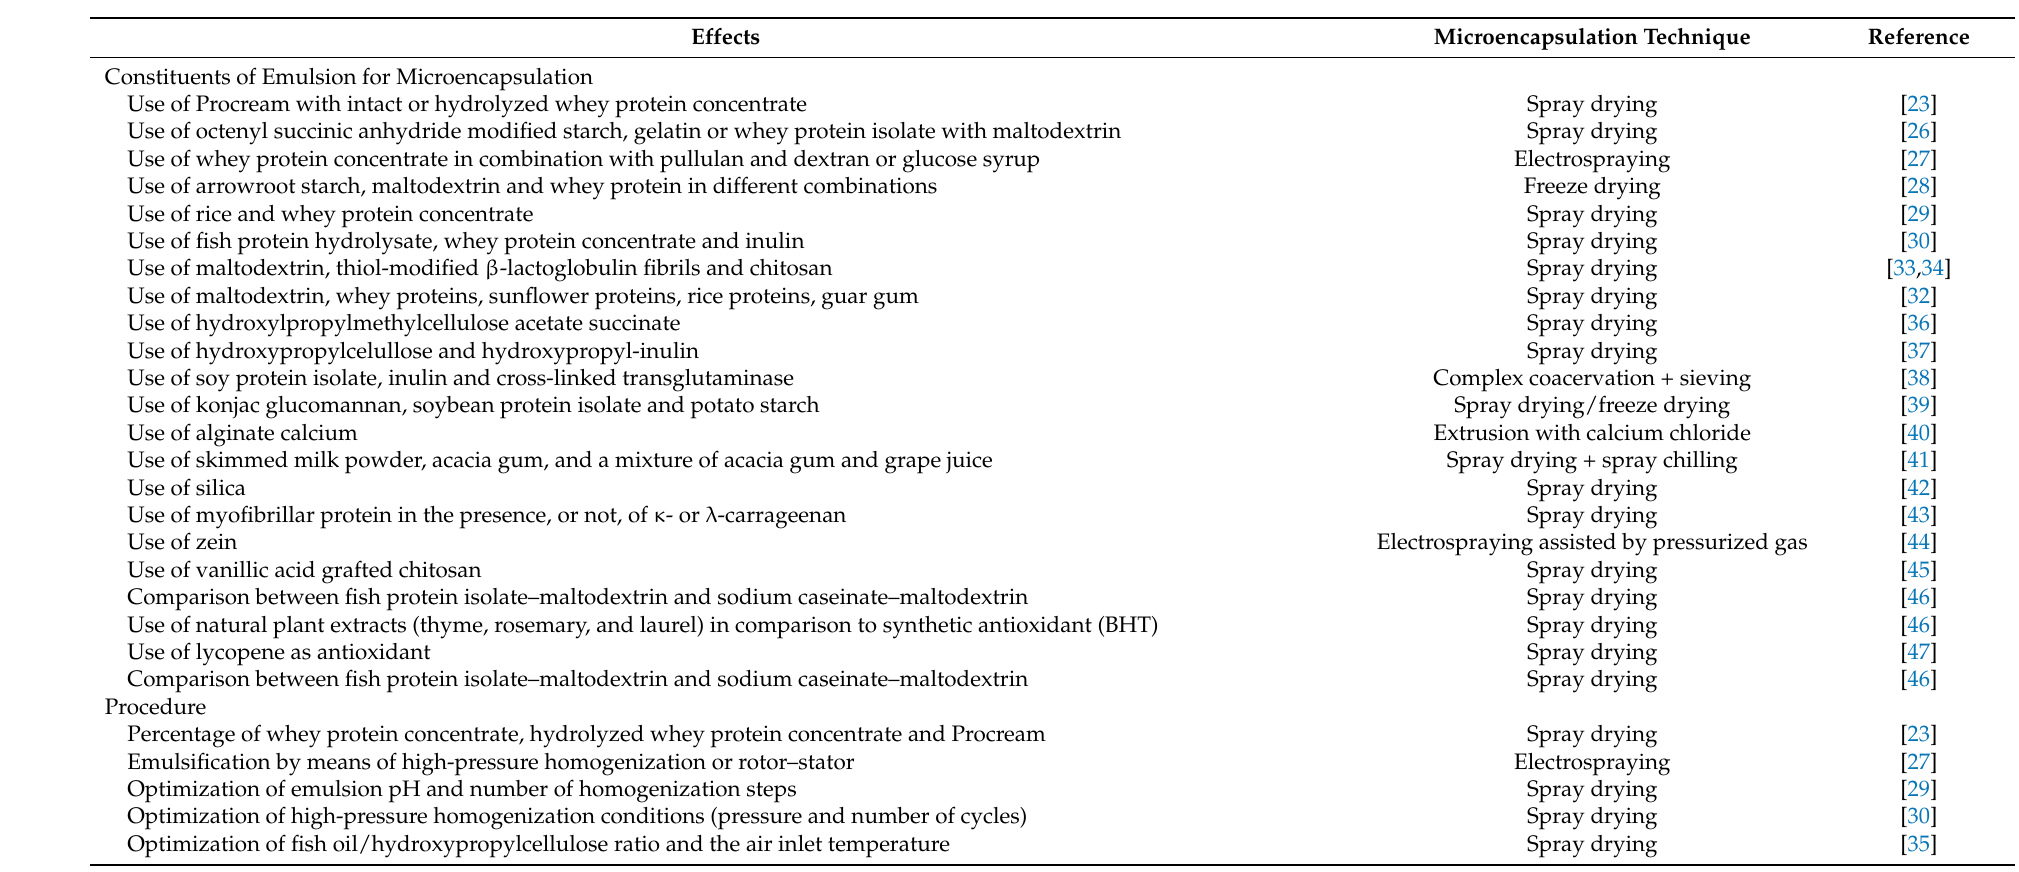
Table 1. Evaluated effect, related to the emulsion constituents, the procedure and the food enrichment, in recent studies for the development of fish oil